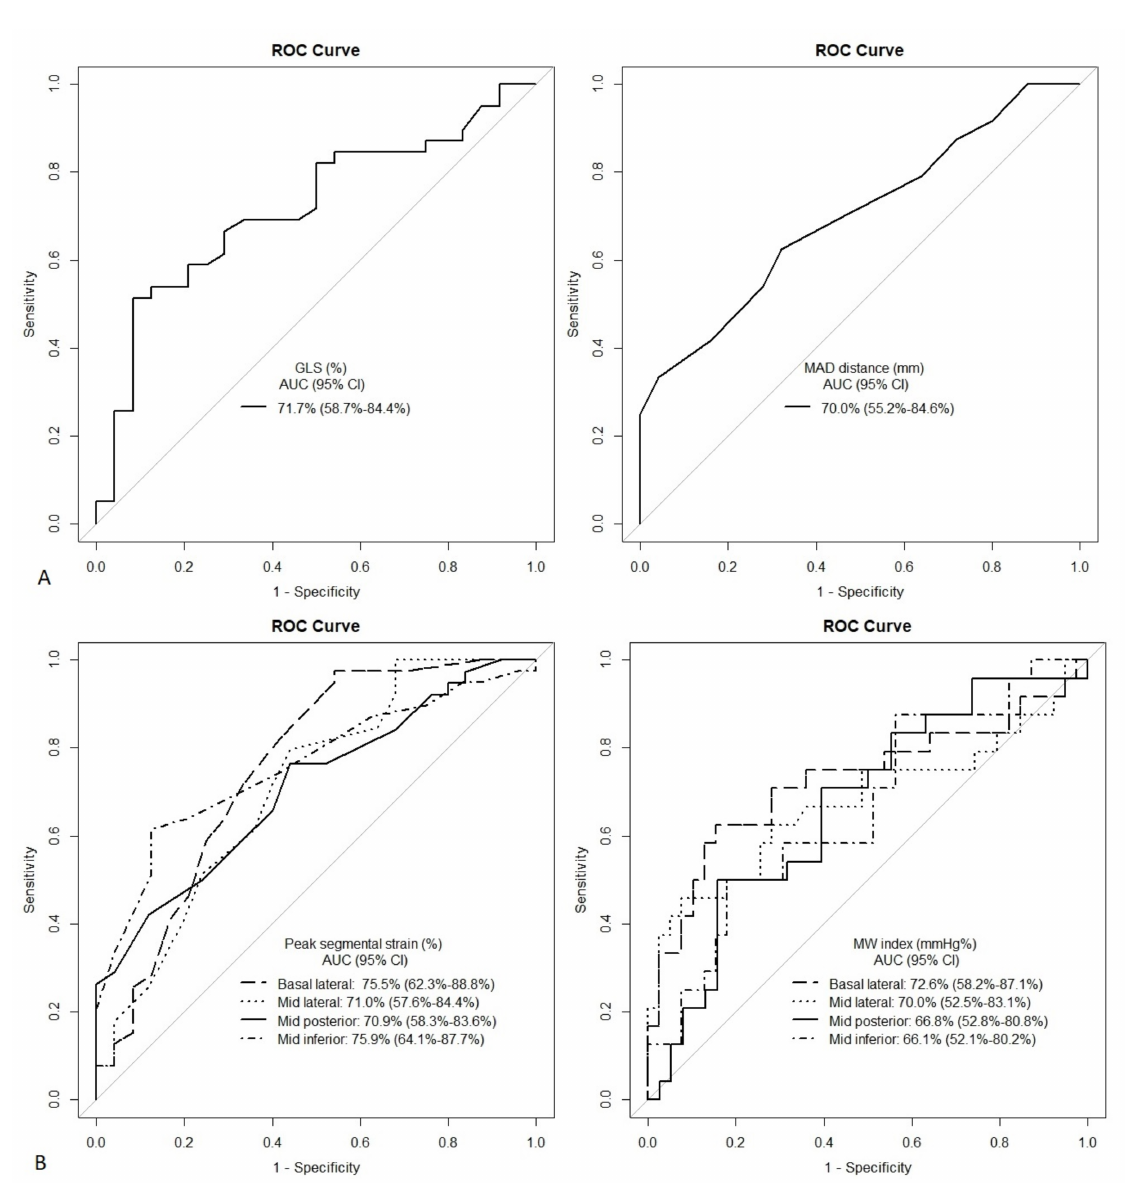
Figure 10. ROC curves of 2D GLS and MAD distance (panel ( A )) and 2D peak segmental strain and segmental MWI parameters (panel ( B